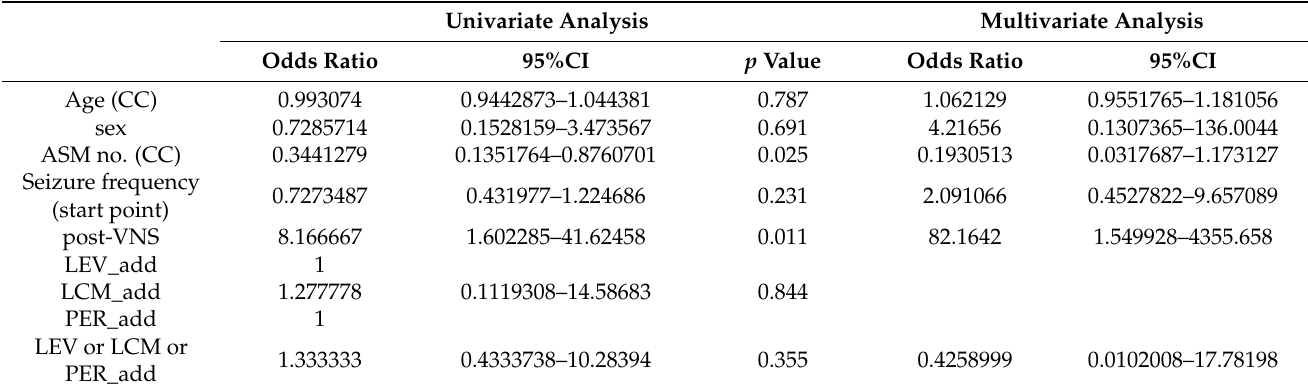
Table 2. Analyses of predictive factors associated with responder rate 1 year after the start